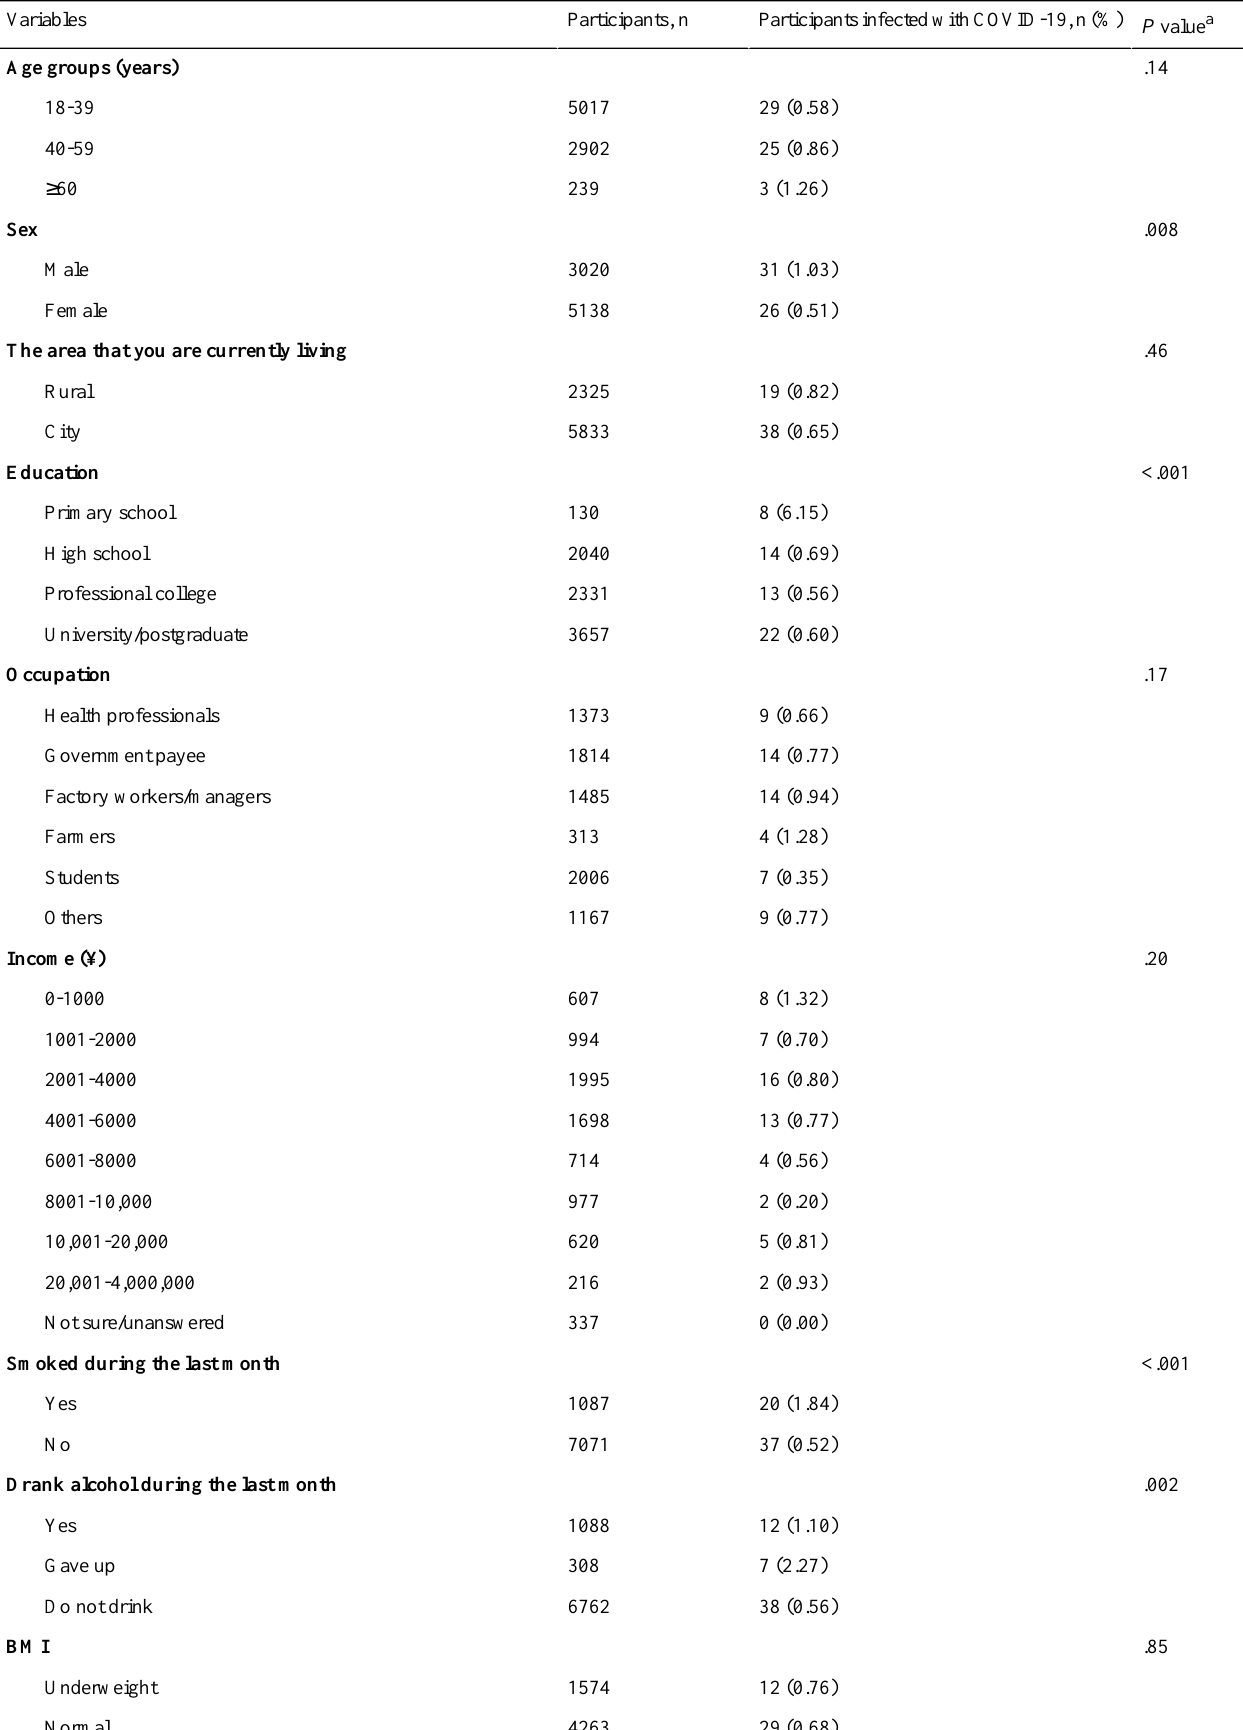
Table 4. The rate of COVID-19 infection (57/8158, 0.7%) across social demographic variables.